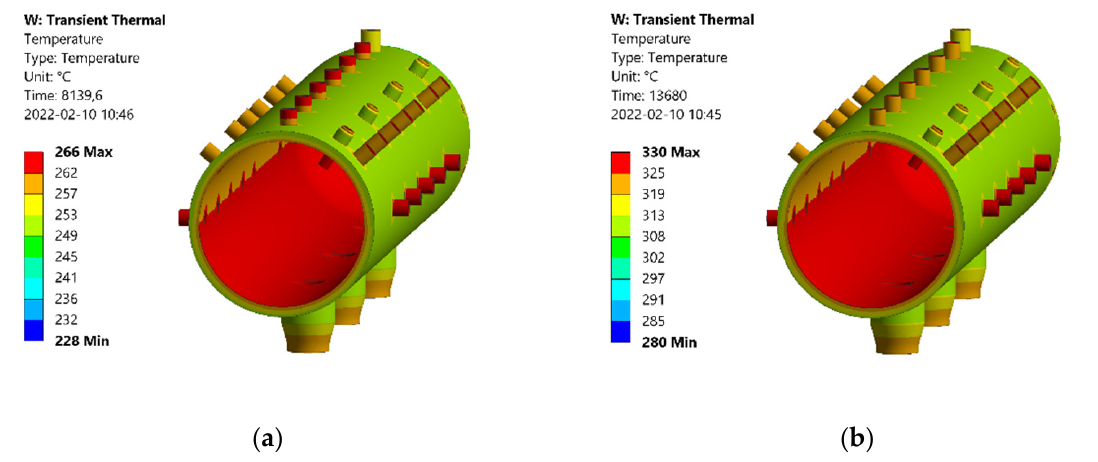
Figure 5. Examples of temperature distribution on the internal and external drum surfaces, and across the planar cross-section, at ( a ) 8140 s into the OR HOT start cycle, and ( b ) at 13,680 s into the OR HOT start cycle.